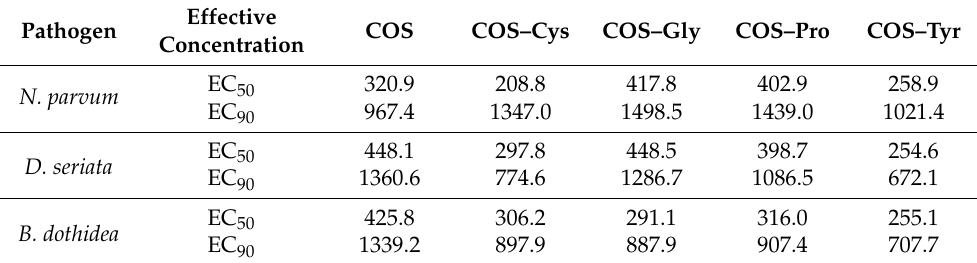
Table 1. EC 50 and EC 90 effective concentrations, expressed in µ g · mL − 1 .